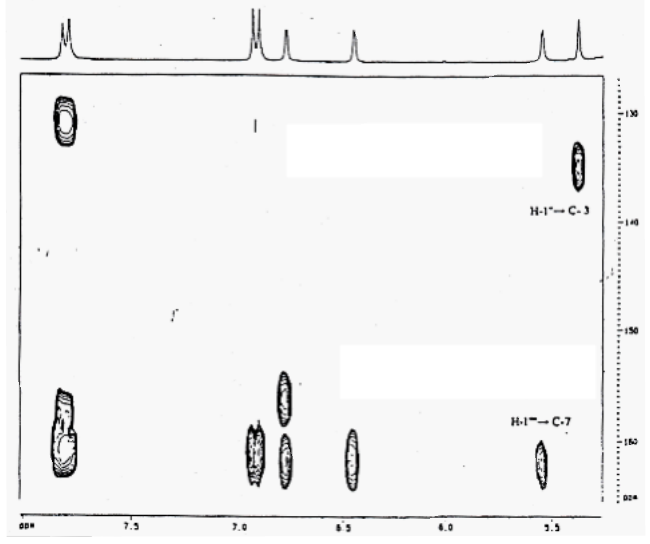
Figure S9: HMBC spectrum of sagittatin A (300 MHz; CD 3 OD). 8 . 0 / 120 - 170 pp m r e g i on . Figure S9 . HMBC spectrum of sagittatin A (300 MHz; CD Magnification of 5.0 - 8.0/120 -170 ppm region. 8.0/120-170 ppm region.